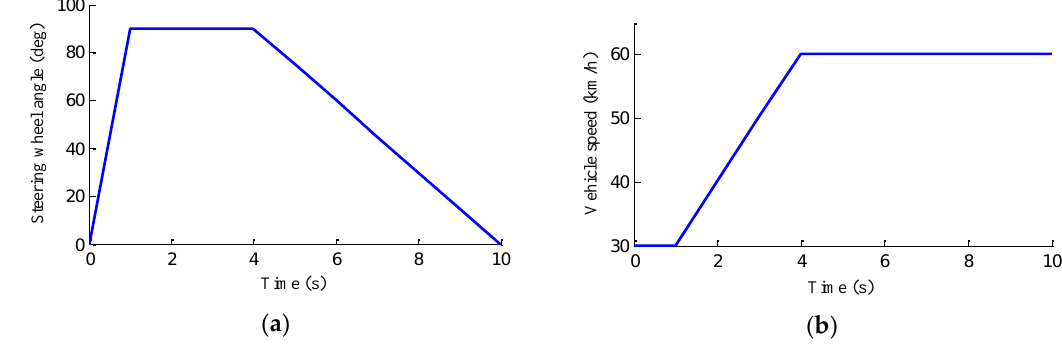
Figure 12. J-turn manoeuvre with a varying speed. ( a ) Steering wheel angle; ( b ) Vehicle speed.